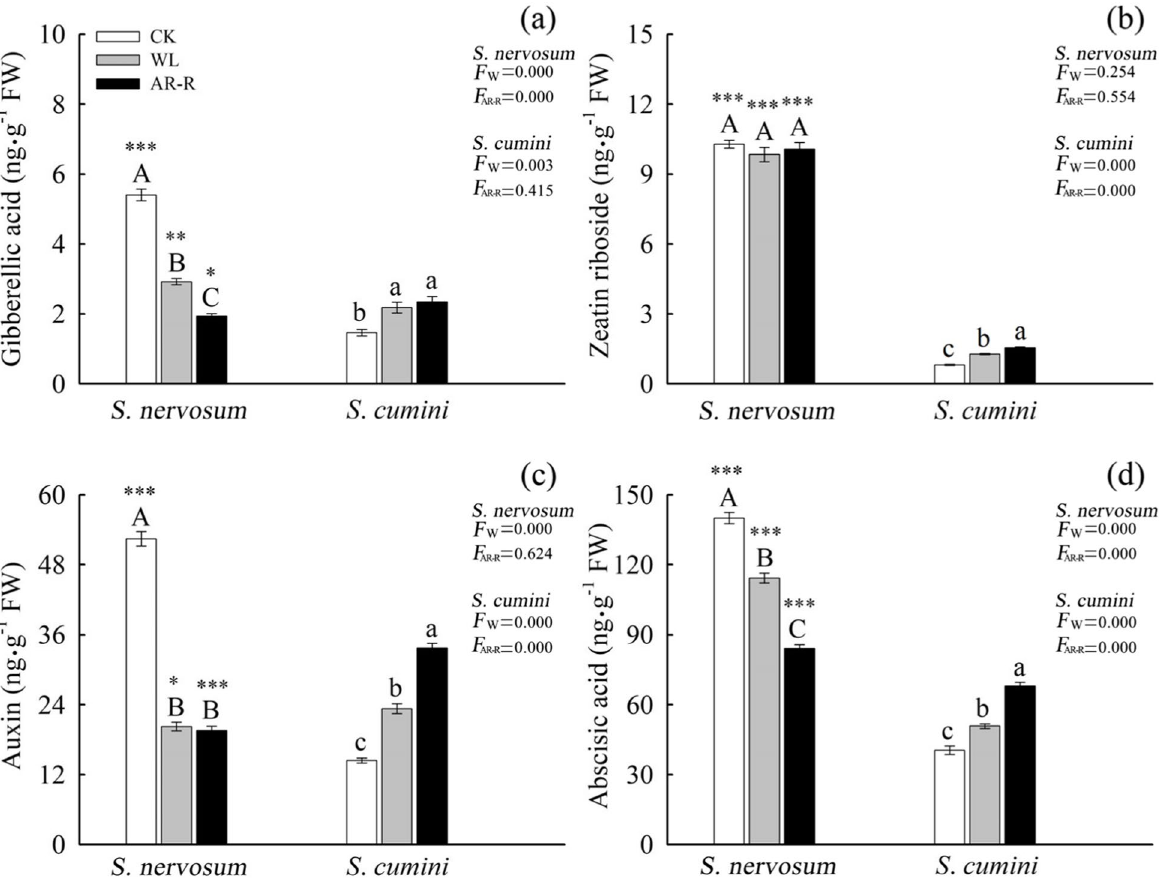
Fig. 6 Gibberellic acid ( a ), zeatin riboside ( b ), auxin ( c ), and abscisic acid ( d ) contents of leaves in S . nervosum and S . cumini saplings, as affected by waterlogging with or without adventitious root removal. The abbreviations, explanation of treatments, and data description and statistics are the same as shown in Fig. 3